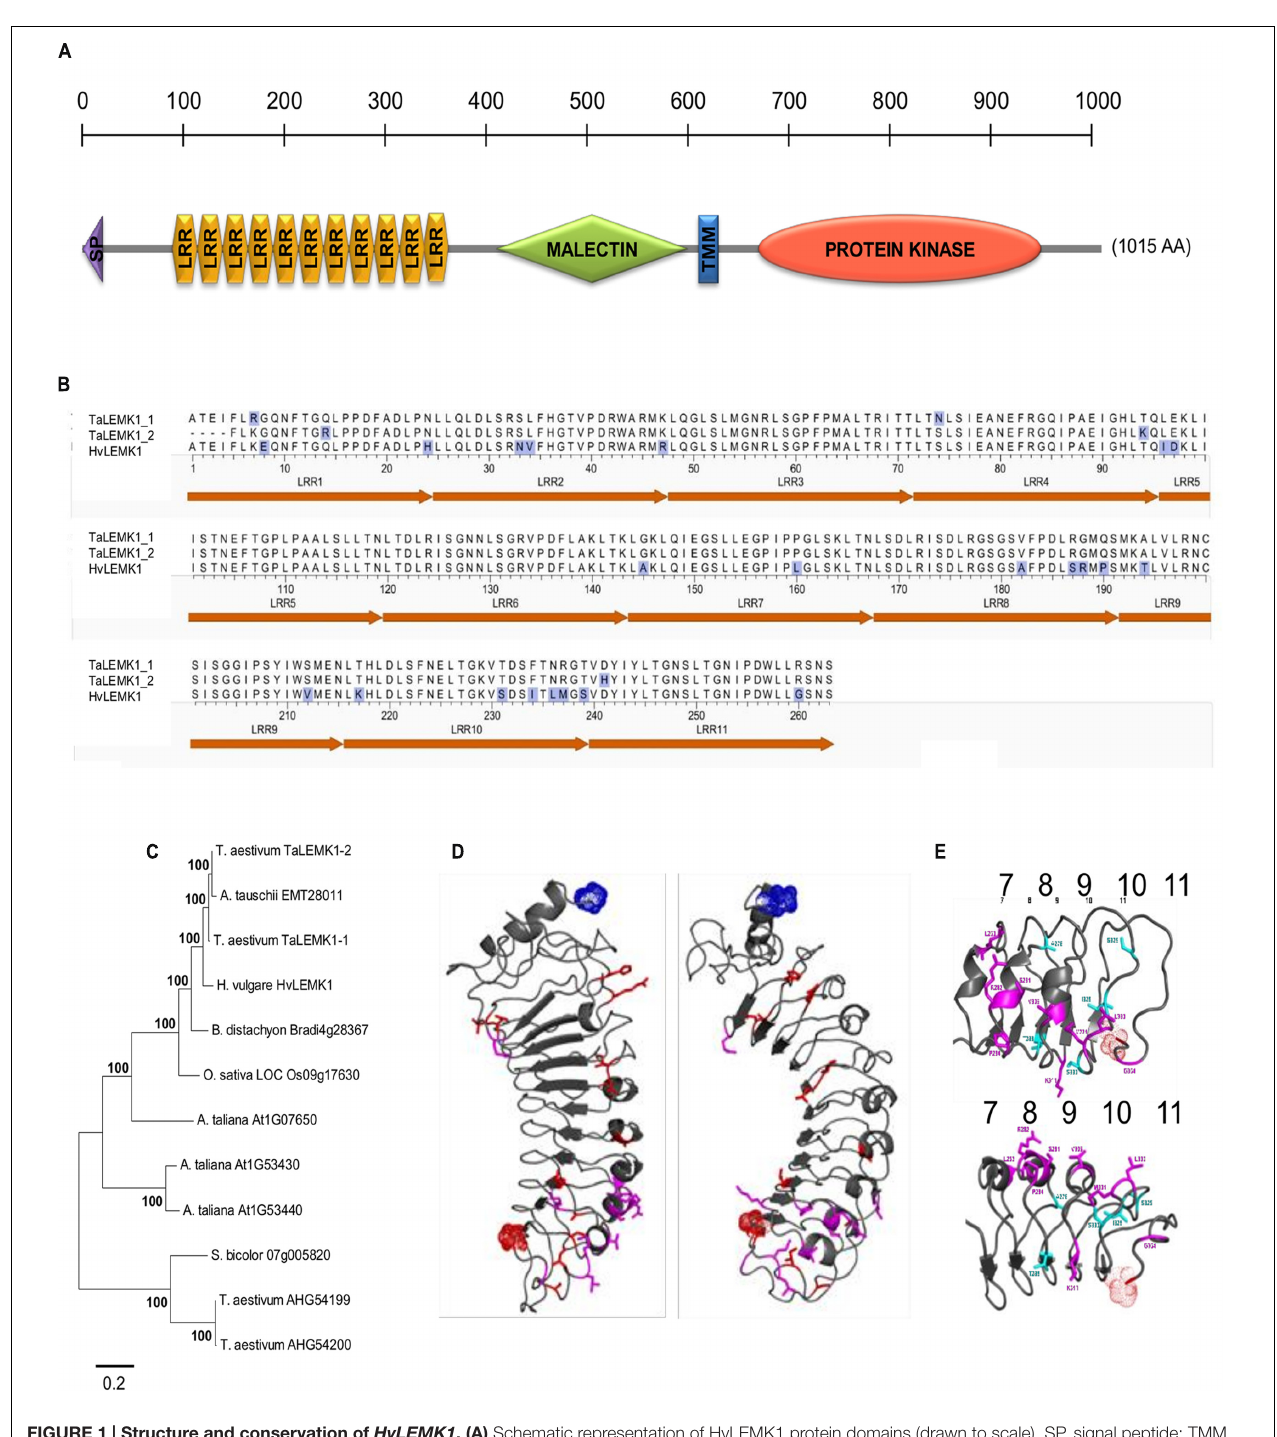
FIGURE 1 | Structure and conservation of HvLEMK1 . (A) Schematic representation of HvLEMK1 protein domains (drawn to scale). SP, signal peptide; TMM, transmembrane domain. (B) Amino-acid comparison of the LRR-repeat domain between barley and wheat LEMK1 proteins. Amino-acid exchanges are highlighted with blue shading. (C) Nearest-neighbor joining tree of full-length LEMK1-like protein sequences across monocot and dicot species. Most closely related homologs (putative orthologs) to HvLEMK1 from Triticum aestivum (bread wheat), Aegilops tauschii (wild wheat, donor of the D genome), Brachypodium distachyon , Oryza sativa (cultivated rice), Sorghum bicolor , and Arabidopsis thaliana were included. In addition, two more distantly related proteins from T. aestivum were included as outgroup. (D) Location of conservative and non-conservative amino-acid substitutions in red and magenta, respectively, among the 11 predicted LRRs. (E) Close-up of most variable repeats 7–11 between barley and wheat orthologs highlighting conservative and non-conservative amino-acid exchanges in light blue and magenta, respectively. The clustering of non-conservative site exchanges on the backside of the repeat structure is clearly visible in the lower part of the panel.